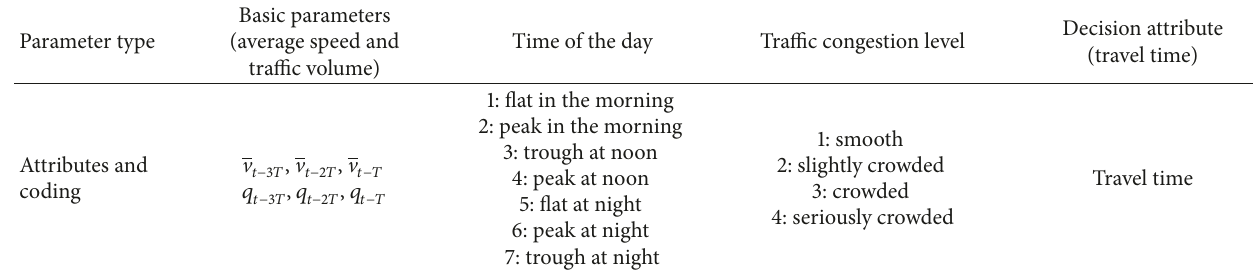
Table 6: Property and encoding of each state component.